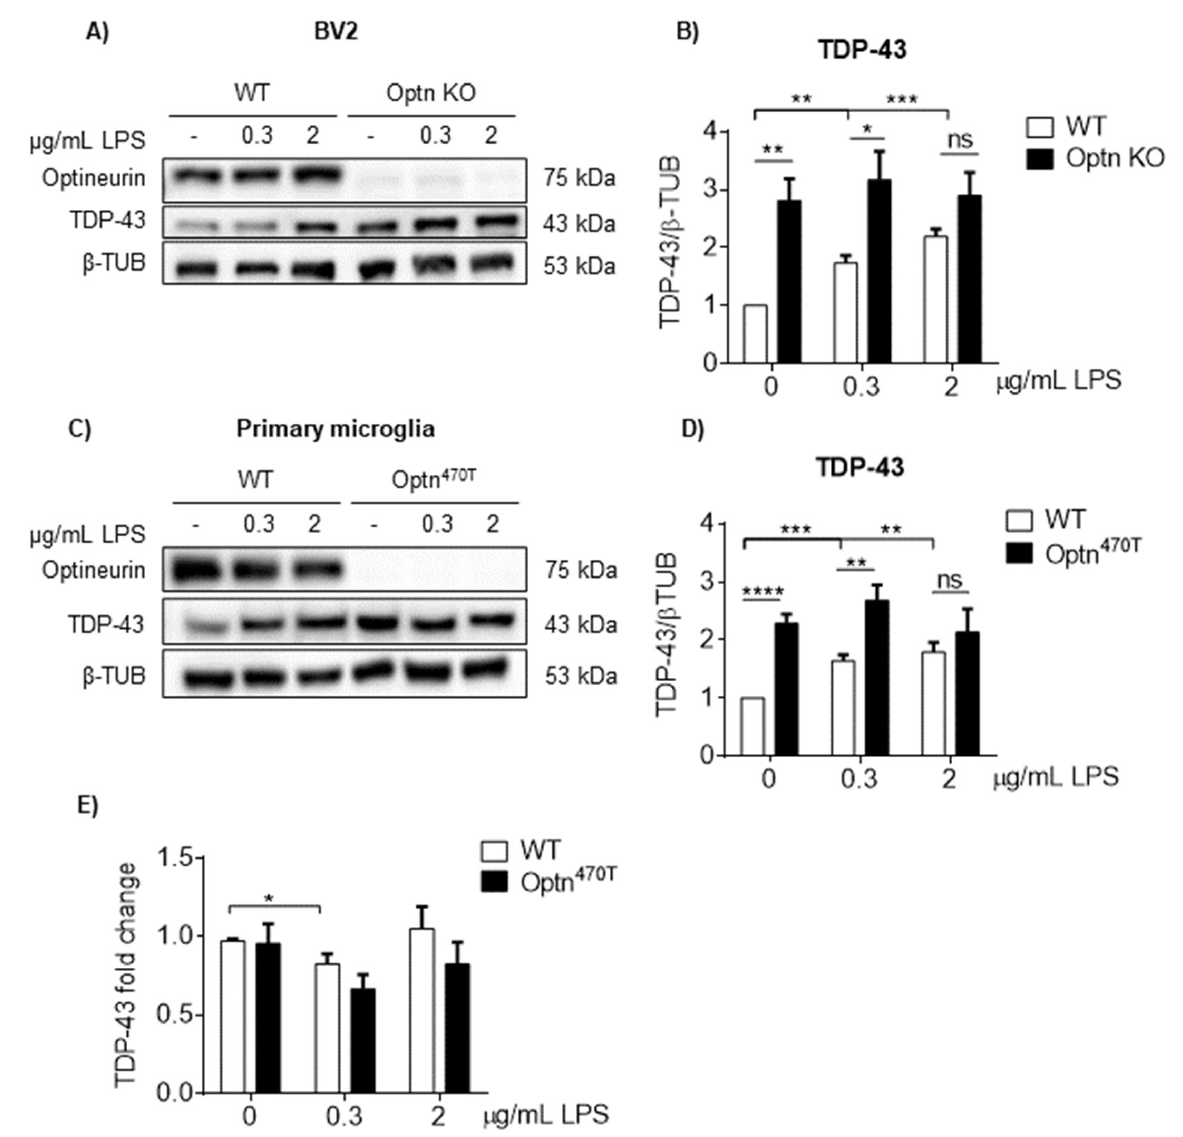
Figure 4. TDP-43 in BV2 Optn KO and Optn 470T microglia remains at the same elevated level as in the basal state and does not increase with LPS treatment. ( A ) Western blotting for TDP-43 and optineurin in WT and Optn KO BV2 cell line upon the indicated doses of LPS for 24 h. ( B ) Bar charts show the densitometric analysis of TDP-43 protein levels normalized to β -tubulin in WT and Optn KO BV2 cell lines. ( C ) Western blotting for TDP-43 and optineurin in WT and Optn 470T primary microglia upon LPS treatment for 24 h. ( D ) Bar charts show the densitometric analysis of TDP-43 protein levels normalized to β -tubulin in WT and Optn 470T primary microglia. ( E ) mRNA for TDP-43 in WT and Optn 470T primary microglia was assessed by RT-PCR 24 h upon LPS treatment. An average ± SEM from 5 independent experiments is shown. Statistical analysis was performed by Student’s t -test: ns, not significant, * p < 0.05, ** p < 0.01, *** p < 0.001, **** p <